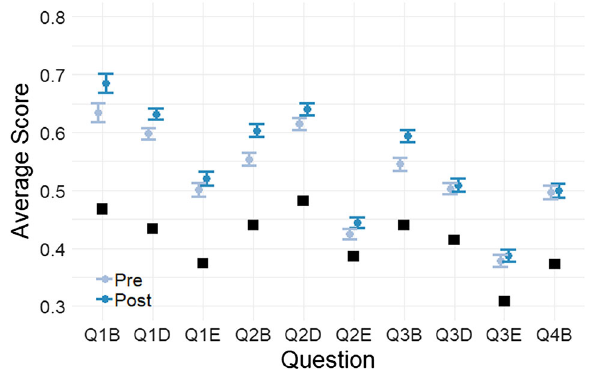
FIG. 2. Average score (representing question difficulty) for each of the 10 PLIC questions. The average expected score that would be obtained through random guessing is marked with a black square. Scores on the first seven questions are statistically different between the pre- and postsurveys (Mann-Whitney U, Holm-Bonferroni corrected α < 0 . 05